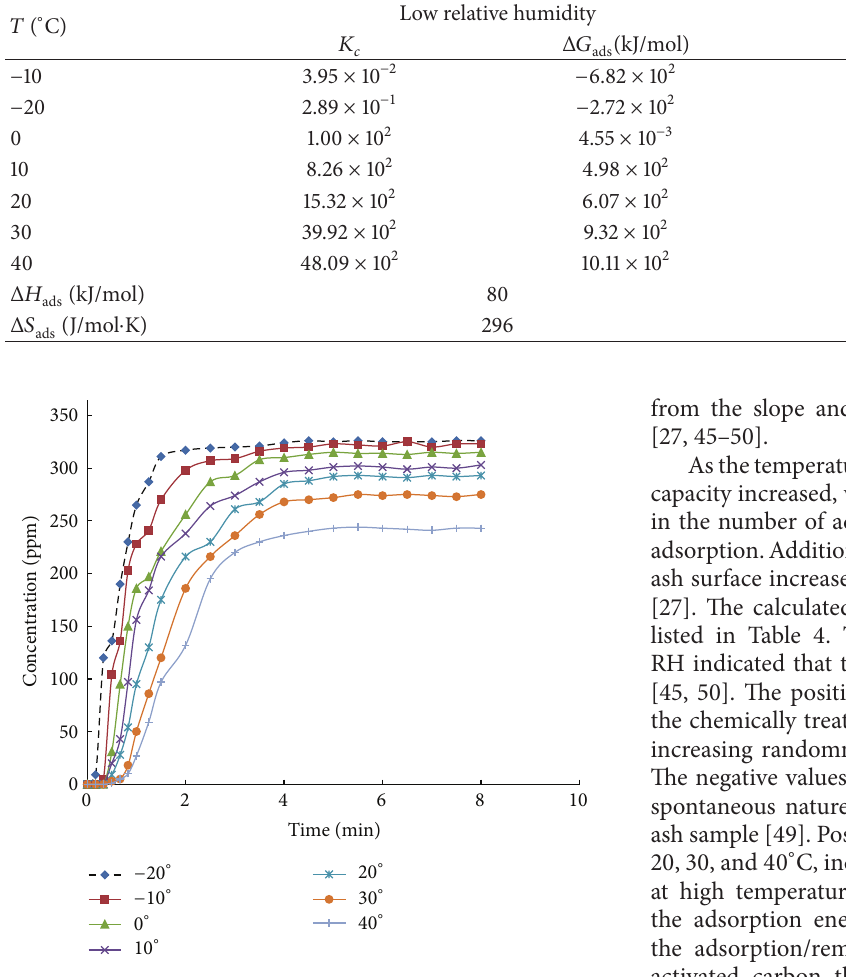
Figure 12: Effect of bed temperature on adsorption of CO 2 onto treated ash. Reaction conditions: initial CO 2 concentration of 350 ppm, CO 2 /N 2 flow rate of 0.3 L/min, 1g ash, and 10%